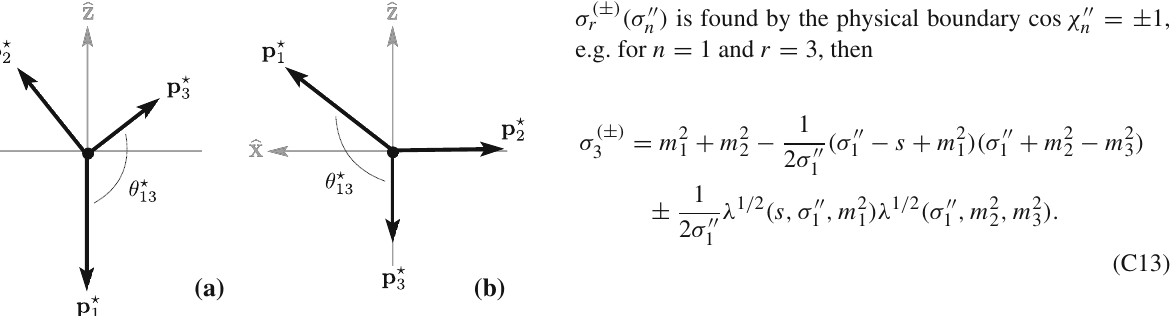
Fig. 19 The standard configurations considering a particle 1 as the spectator and b particle 3 as the